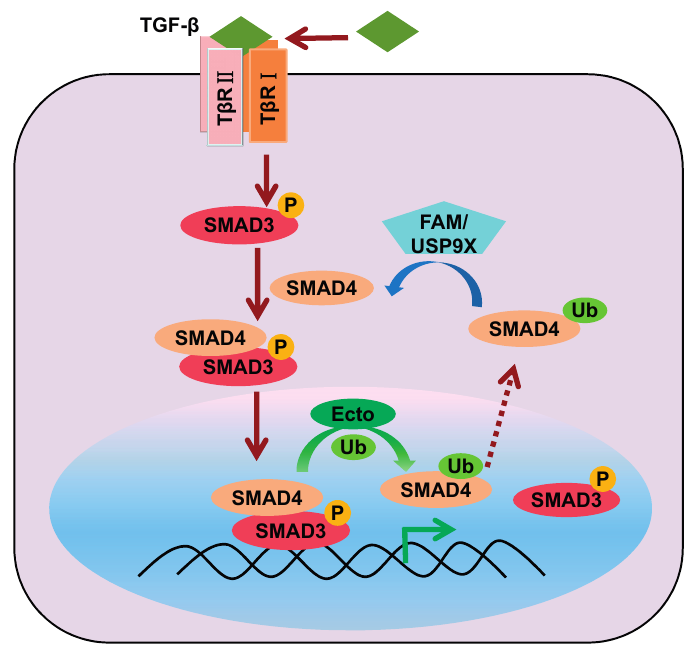
Figure 4. Regulation of SMAD4 mono-ubiquitination by Ectodermin and FAM/USP9X.